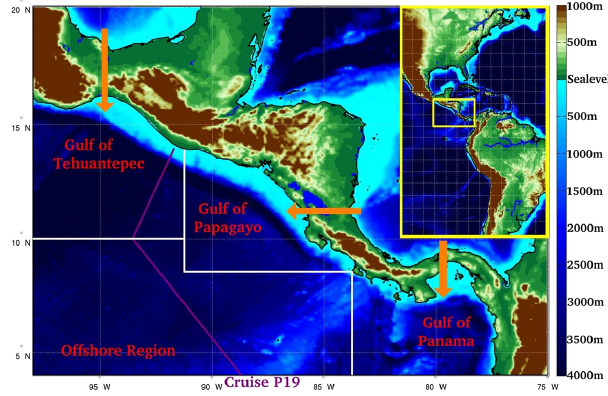
Figure 1. The topography of the eastern tropical Pacific Ocean and Isthmus of Panama, plotted using the General Bathymetric Chart of the Oceans (GEBCO; http://www.gebco.net/) bathymetry. The three gulfs within the region, Panama (84 ◦ W from coastline of Panama), Papagayo (84 to 91 ◦ W, north of 8 ◦ N) and Tehuantepec (west of 91 ◦ W, north of 10 ◦ N), and the offshore region, are marked in white. The transect of WOCE cruise P19 is indicated in purple. The paths of jet winds are marked by orange